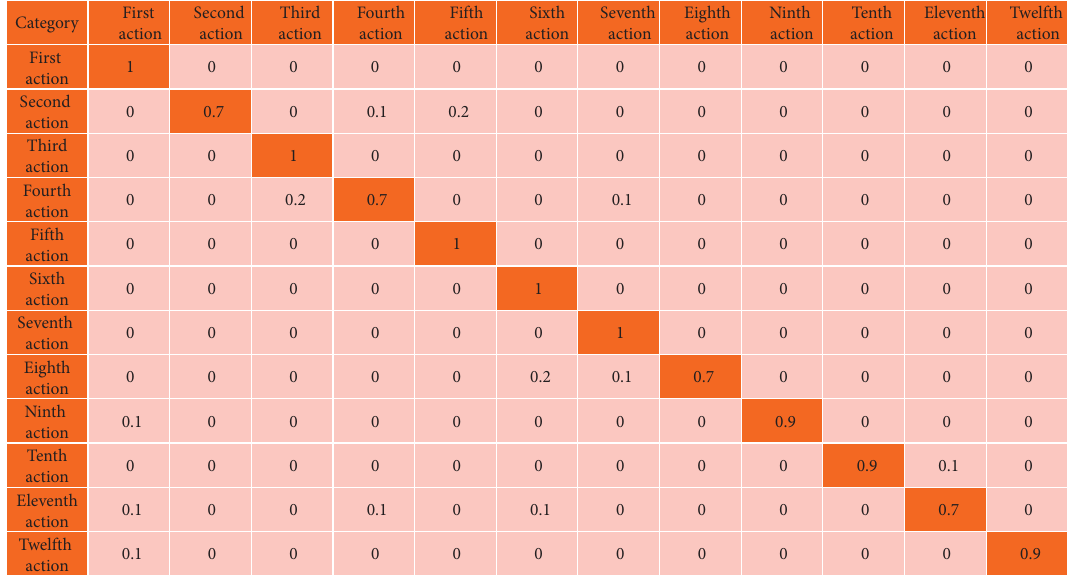
Figure 11: Confusion matrix of PLCNN in Exercise A.